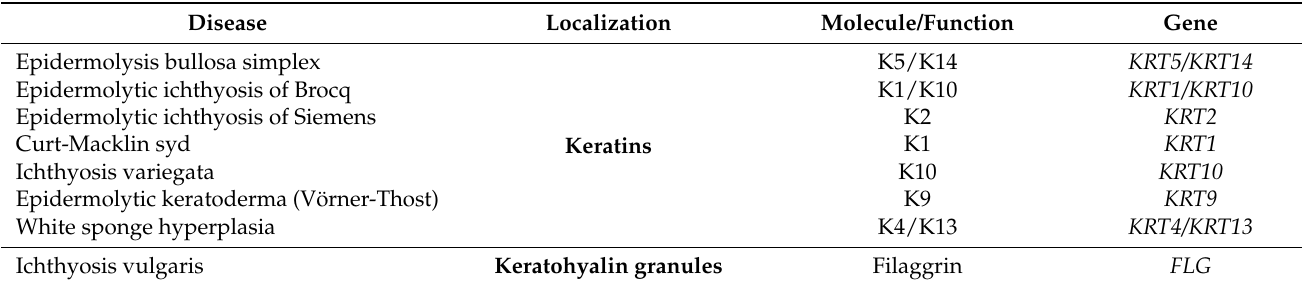
Table 1. Epidermal Differentiation-related Genetic Disorders. Adapted from Oji et al. [42]. Syd: syndrome; K: keratin; AR: autosomal